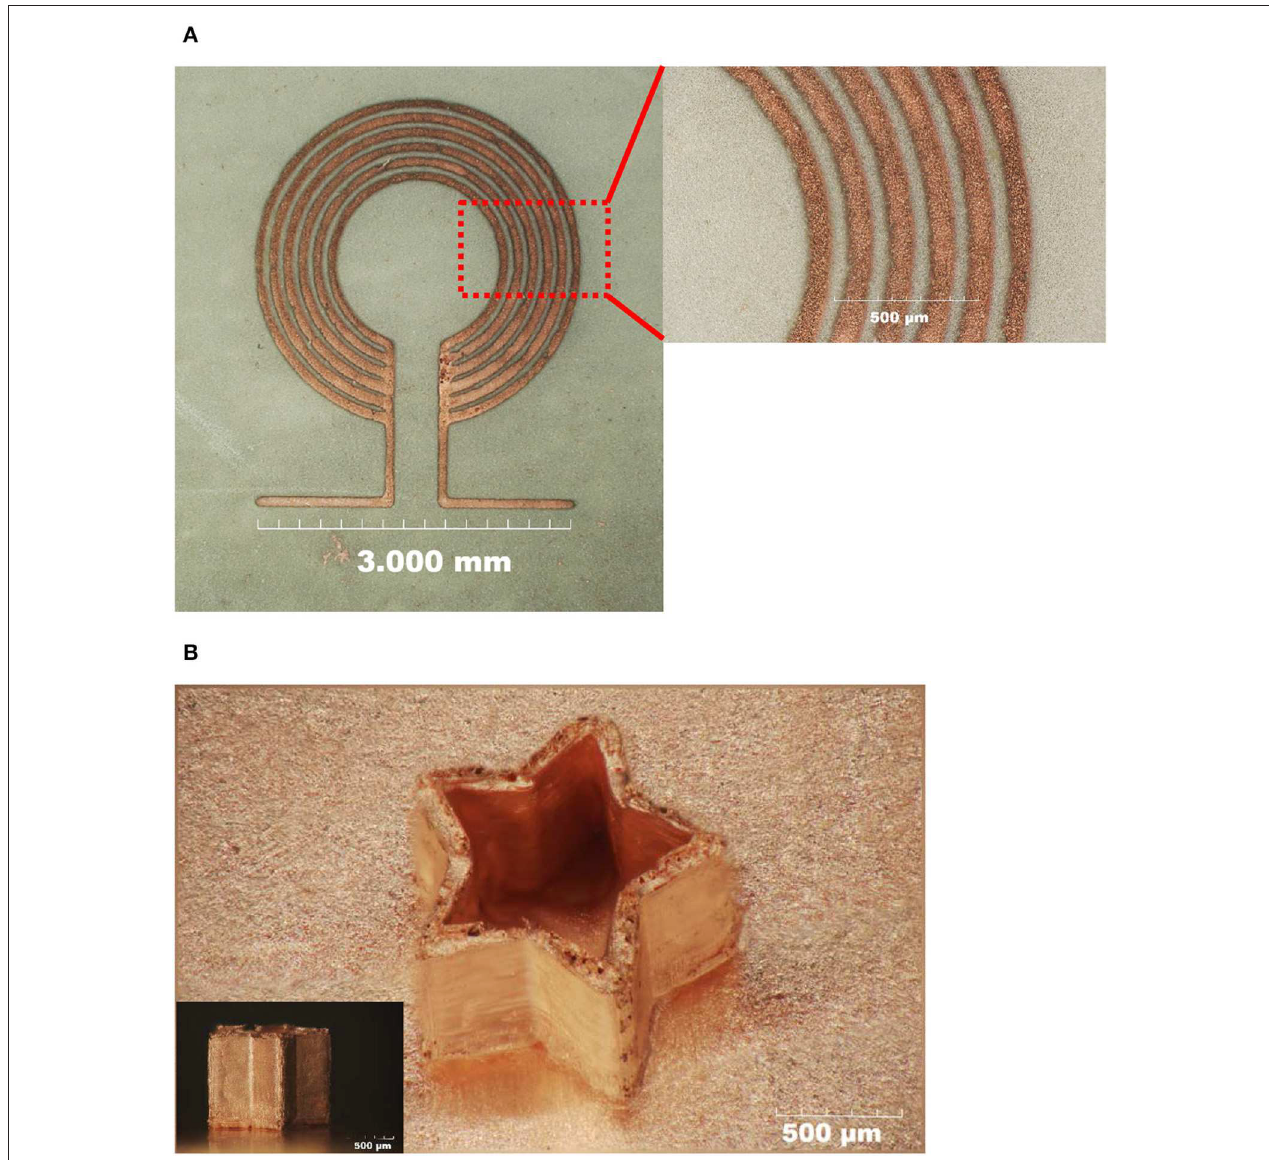
FIGURE 9 | (A) The 2D micro-coils structure and (B) the 3D star-like structure fabricated using electrochemical 3D printing